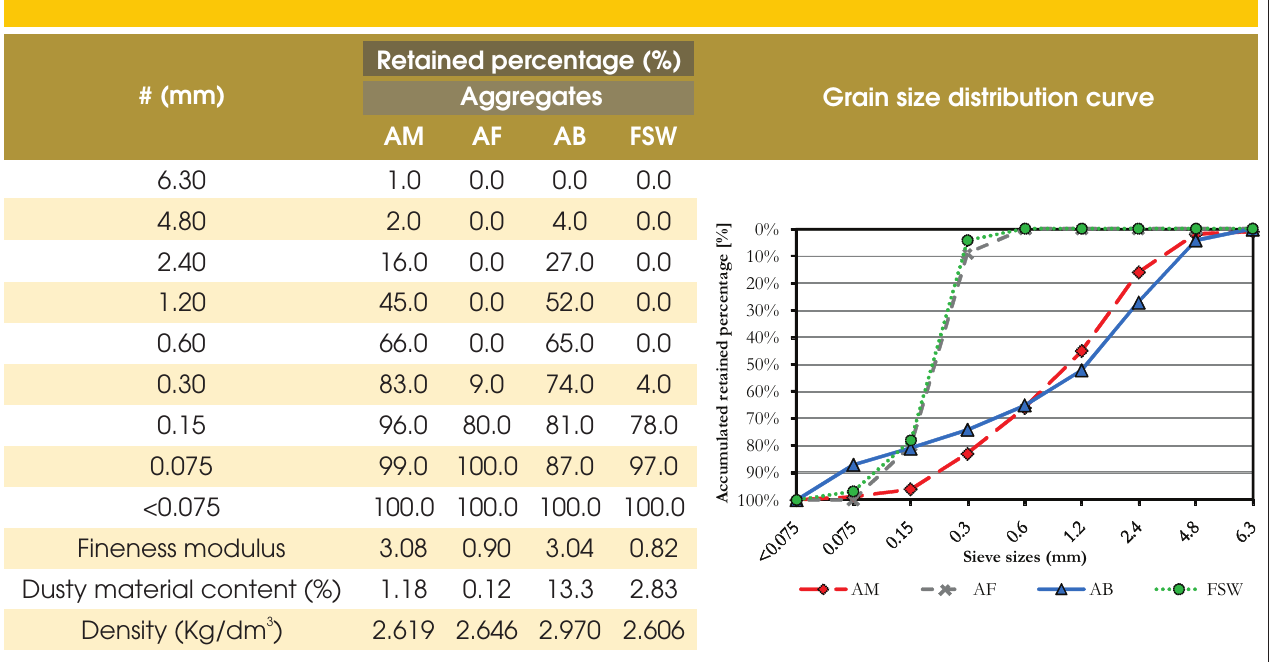
Table 4 – Physical properties of different types of